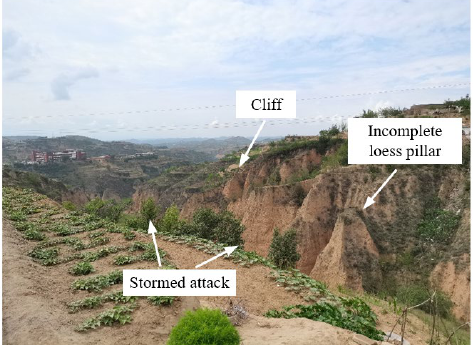
Figure 1. The actual valley terrain in a sedimentary bauxite area in Shanxi.